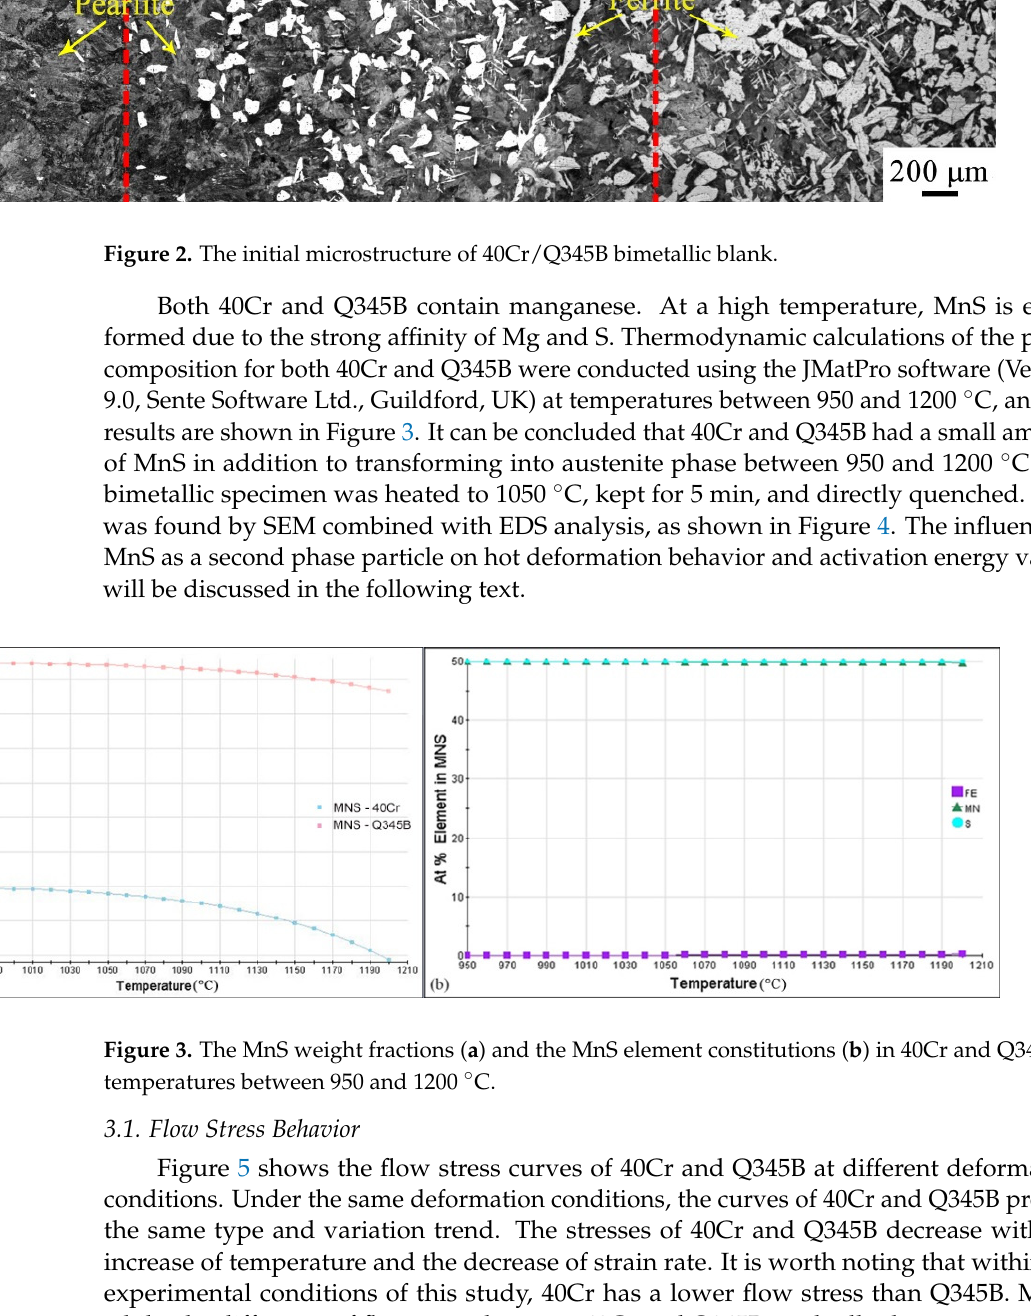
Figure 4. SEM images ( a ) and EDS spectra ( b ) of MnS in 40Cr/Q345B bimetallic blank.